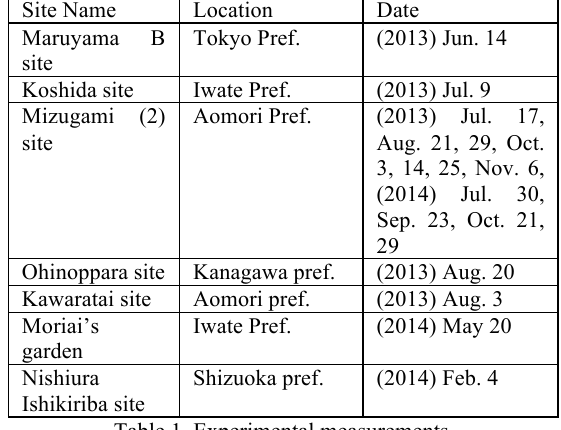
Table 1. Experimental measurements